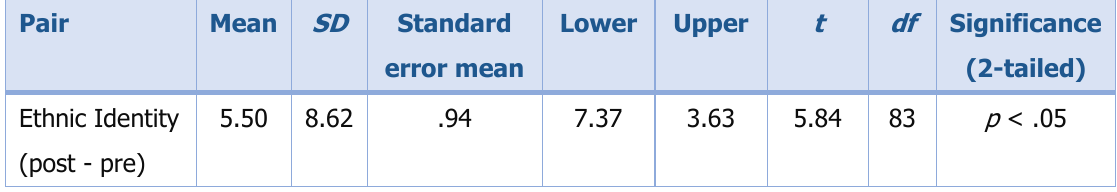
Table 3. Ethnic Identity Growth Statistics Paired Sample T-Test